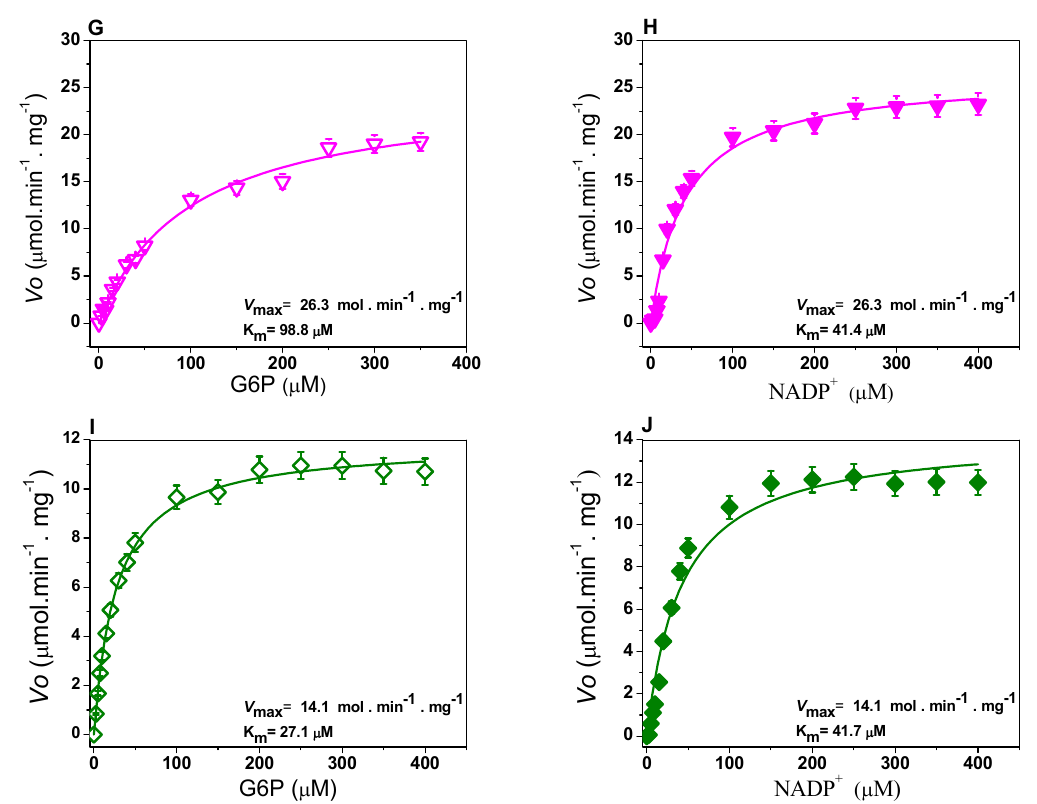
Figure 5. Kinetic characterization of ( A , B ) human G6PD WT and three single mutants: ( C , D ) G6PD A + (Asn126Asp), ( E , F ) G6PD San Luis Potosi (Asn126Tyr), ( G , H ) G6PD Guadalajara (Arg387Cys); and ( I , J ) double mutant G6PD Monte Sinai. Initial velocities ( V o) of each concentration of G6PD physiological substrate (G6P and NADP + ) were fitted to the Michaelis–Menten equation by nonlinear regression calculation to obtain V max and K m values. All assays were performed in triplicate.